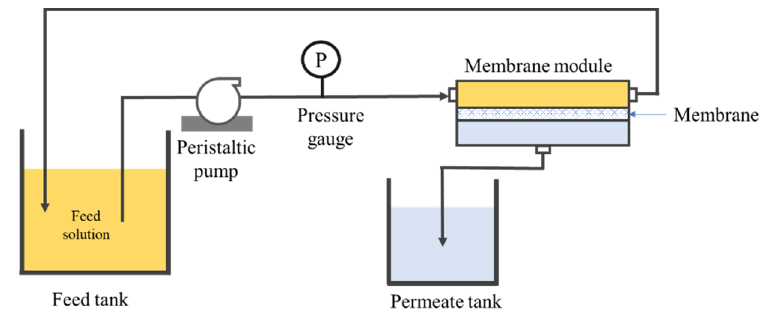
Figure 2. Schematic diagram of the crossflow filtration setup.